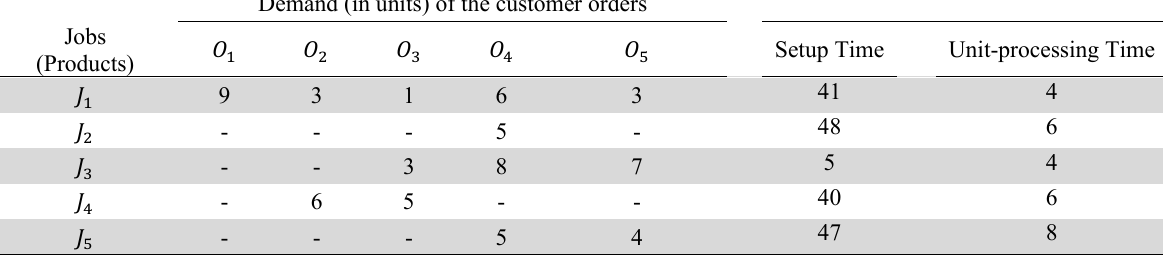
Table A.1 Data set for the numerical example Demand (in units) of the customer